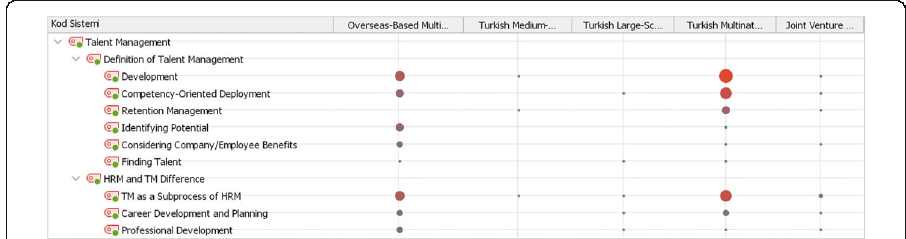
Fig. 2 Expressions of talent management and HRM-TM difference via company